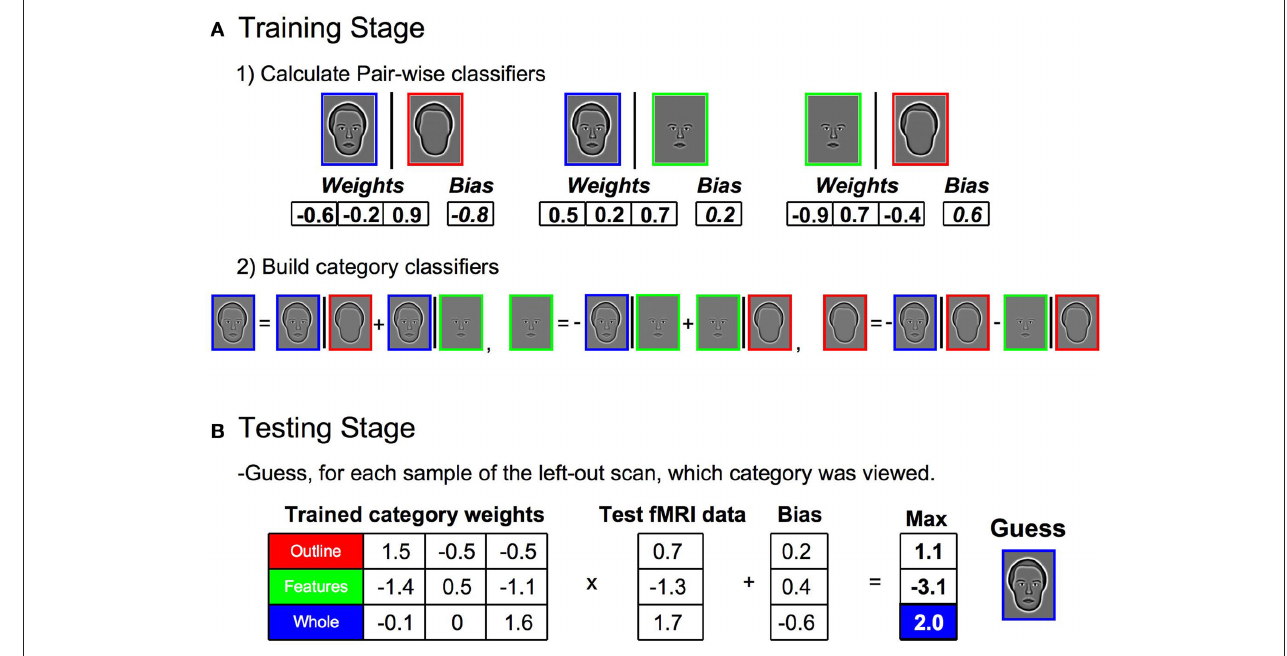
inversion of the sign of the weights. The three category classifiers together comprised the multi-class classifier. (B) During the testing stage, the samples from the left-out scan were independently classified through a matrix multiplication of the trained classifier weights and the sample response vector. The resulting product was adjusted by the biases and the maximum response was taken as the guess for the category to which a particular sample belonged. The entire process (A, B) was then repeated, leaving out a different scan each time, until all samples were part of a test set exactly